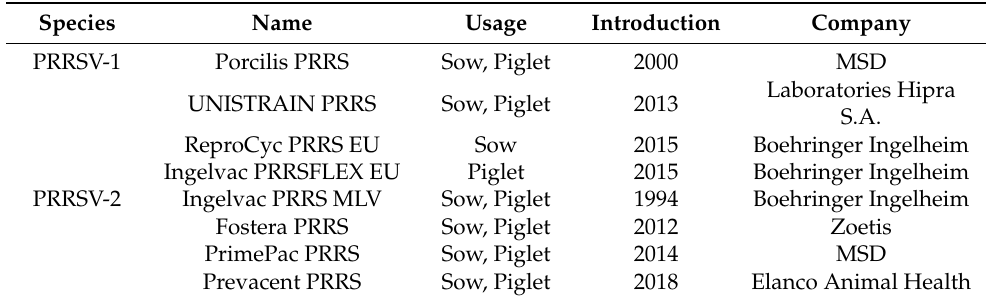
Table 1. Major Porcine reproductive and respiratory syndrome (PRRS) modified-live virus (MLV) vaccines used in